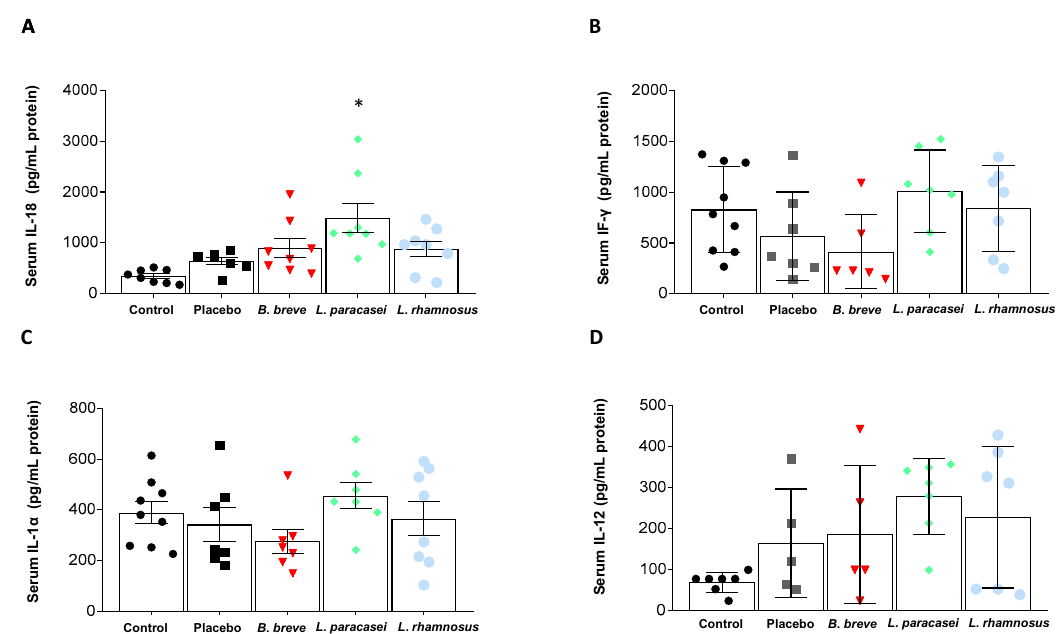
Figure 3. Serum concentration of pro-inflammatory cytokines. ( A ) IL-18, ( B ) INF- γ , ( C ) IL-1 α , and ( D ) IL-12 of rats fed either placebo, B. breve CNCM I-4035, L. paracasei CNCM I-4034 or L. rhamnosus CNCM I-4036 for 30 days. Values are the means ± SEM. n = 8 per group. * p < 0.05 vs. placebo. B, Bifidobacterium ; INF- γ , interferon-gamma; IL, interleukin; L, Lactobacillus .